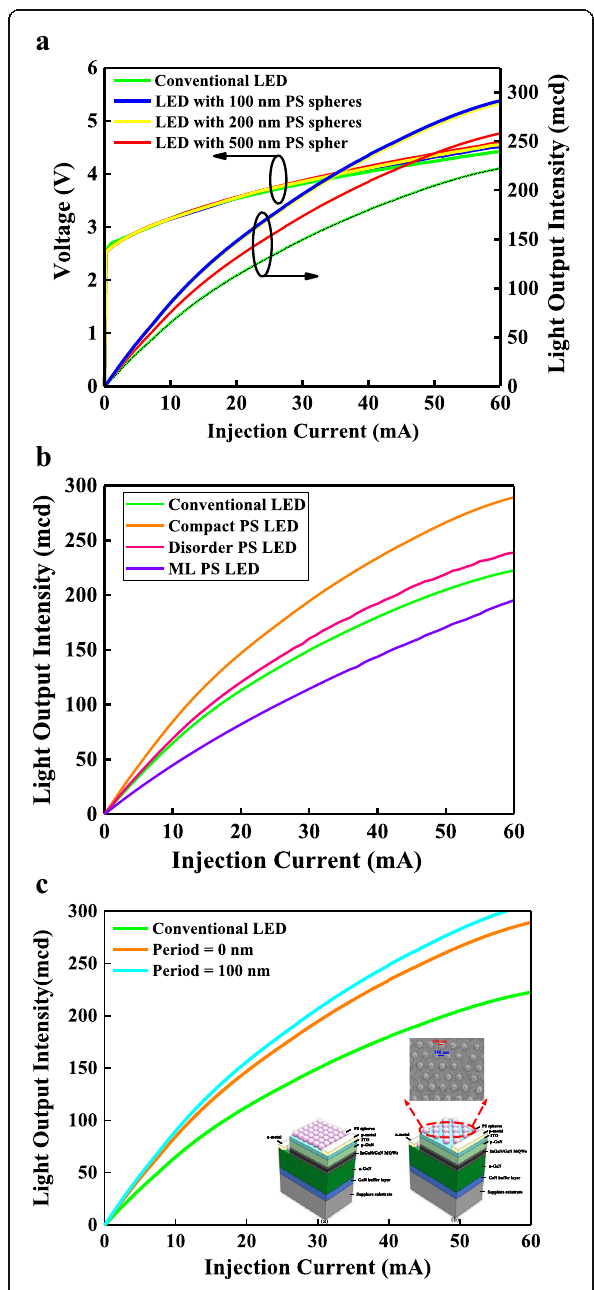
Fig. 5 a I-V and L-I curves for the conventional InGaN/GaN LED and InGaN/GaN LED with compact PS NS array window layers of 100-, 200-, and 500-nm-diameter PS NSs. b L-I curves for the conventional InGaN/ GaN LEDs and InGaN/GaN LEDs with periodic, disorder, and multilayer PS array window layers. c L-I curves for the conventional InGaN/GaN LEDs and InGaN/GaN LEDs with compact and optimal periodic PS NS array window layers. The inset of ( c ) shows the schematic structures of InGaN/GaN LEDs with compact and periodic PS array. The SEM image of the periodic PS array the also represents in the inset of Fig.